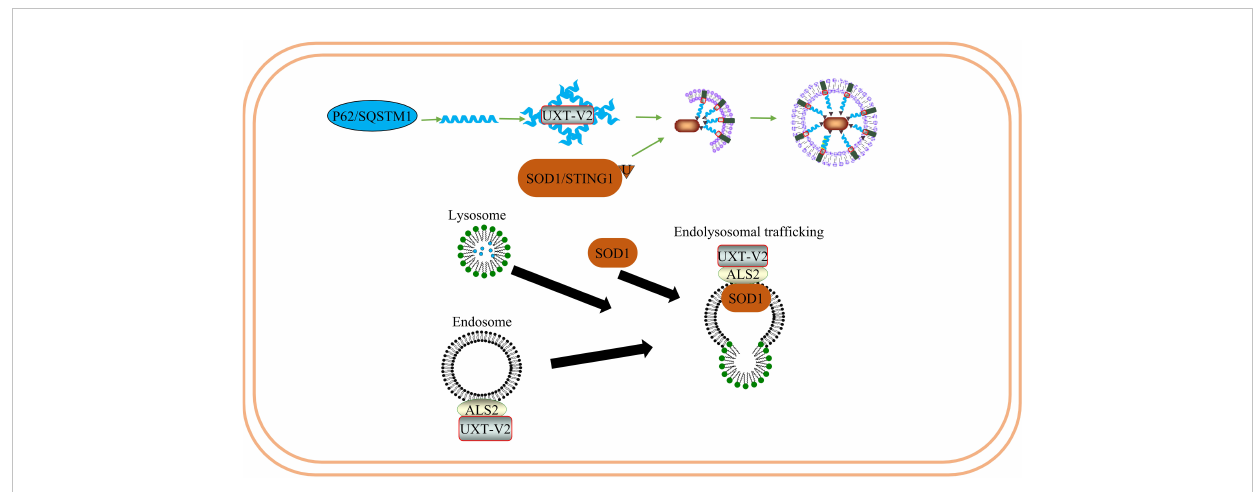
FIGURE 8 UXT regulates the degradation of SOD1 protein aggregates in ALS: UXT-V2 promotes autophagy degradation of P62 - mediated SOD1 protein aggregates. UXT-V2 promotes endolysosomal traf fi cking of SOD1 protein aggregates by binding to ALS2.